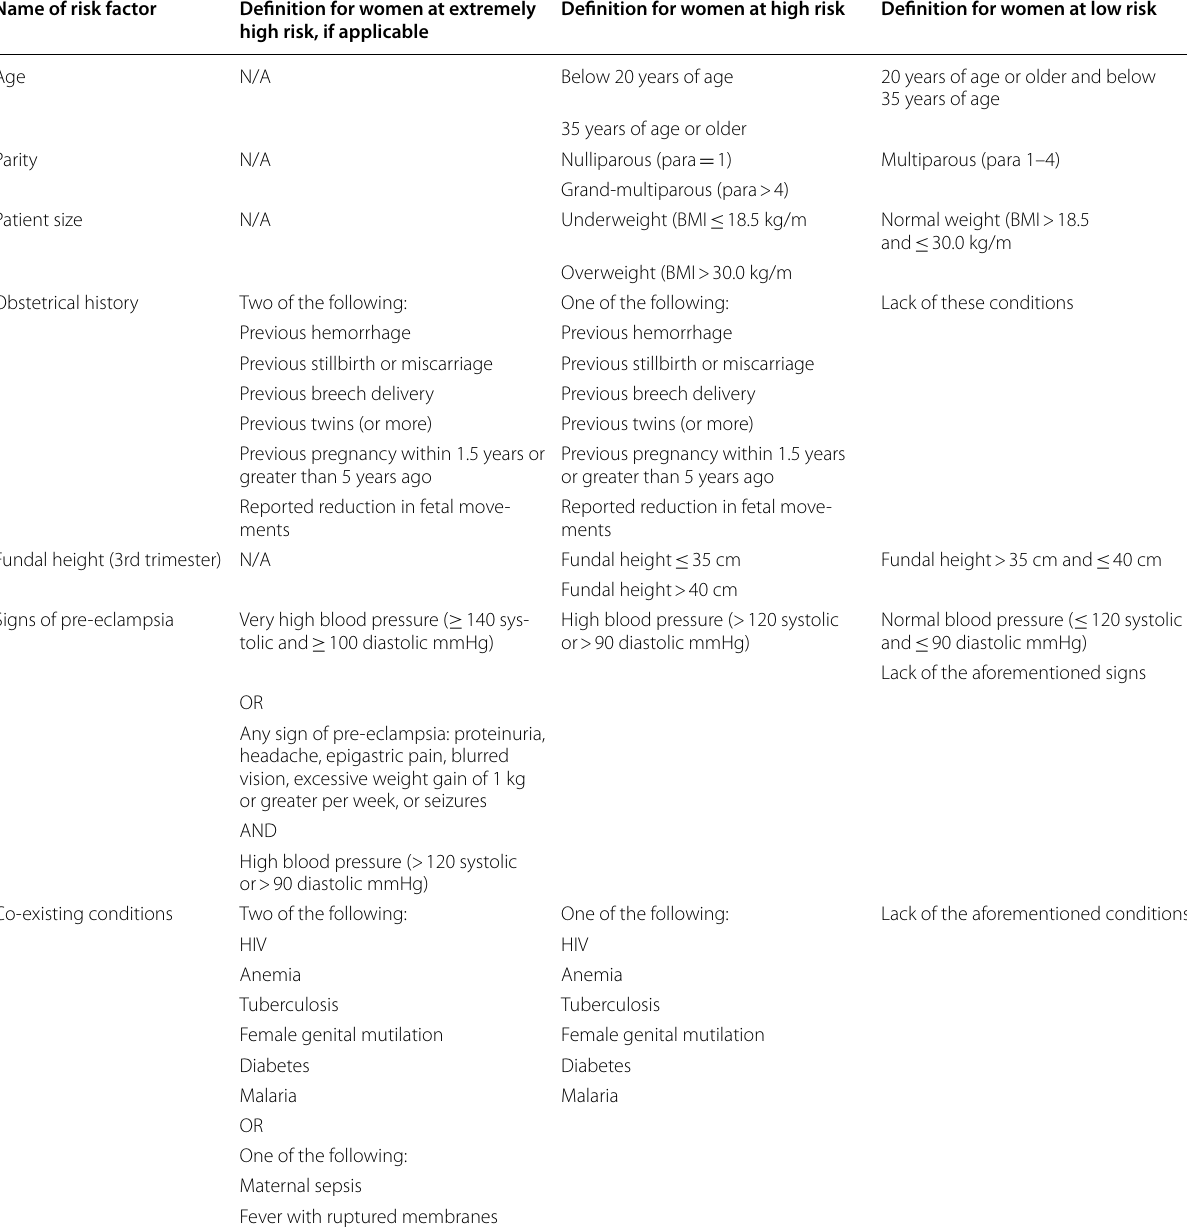
Table 1 Summary of the 7 domains of the CMDS, including risk-definitions for extremely high risk, high risk, and low risk women Name of risk